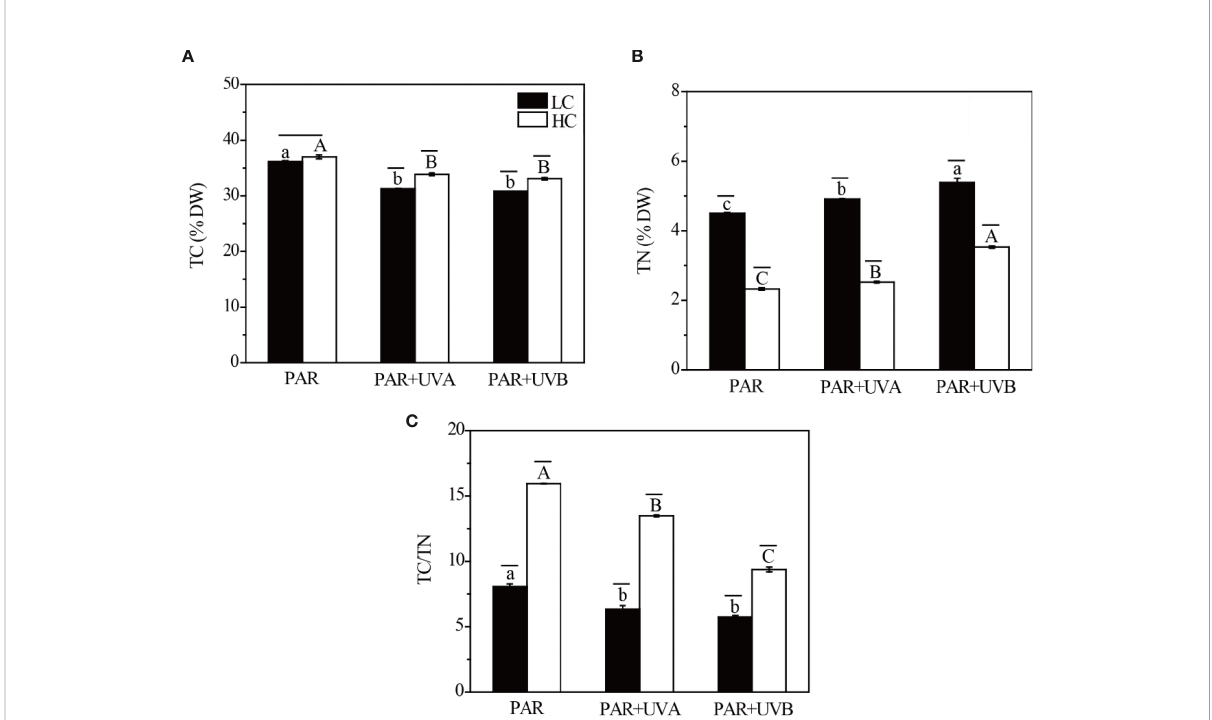
FIGURE 6 The TC (A) , TN (B) contents and TC/TN ratios (C) of Rhodosorus sp. SCSIO-45730 treated under different p CO 2 levels and UVR. Short horizontal lines represent signi fi cant differences (P<0.05) among CO 2 treatments at the same UVR treatment, while long horizontal lines indicate insigni fi cant differences. Different lowercase letters represent signi fi cant differences (P<0.05) among UVR treatments under LC, and different capital letters indicate signi fi cant differences (P<0.05) among UVR treatments under